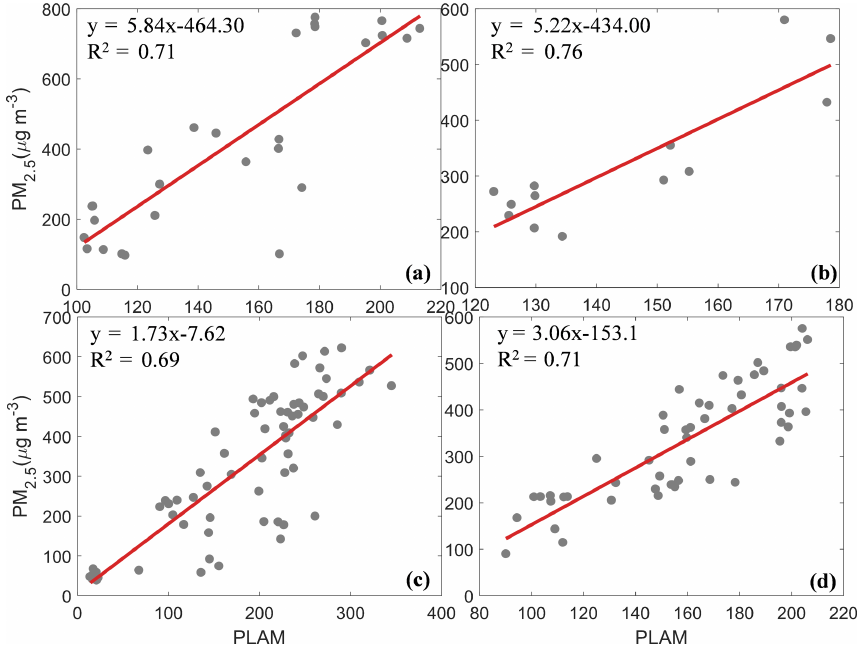
Figure 7. Correlation between PLAM and PM2.5 during the cumulative explosive growth processes in January 2013 (a) , December 2015 (c) and December 2016 (d) and the convergent explosive growth processes in February 2014 (b) .